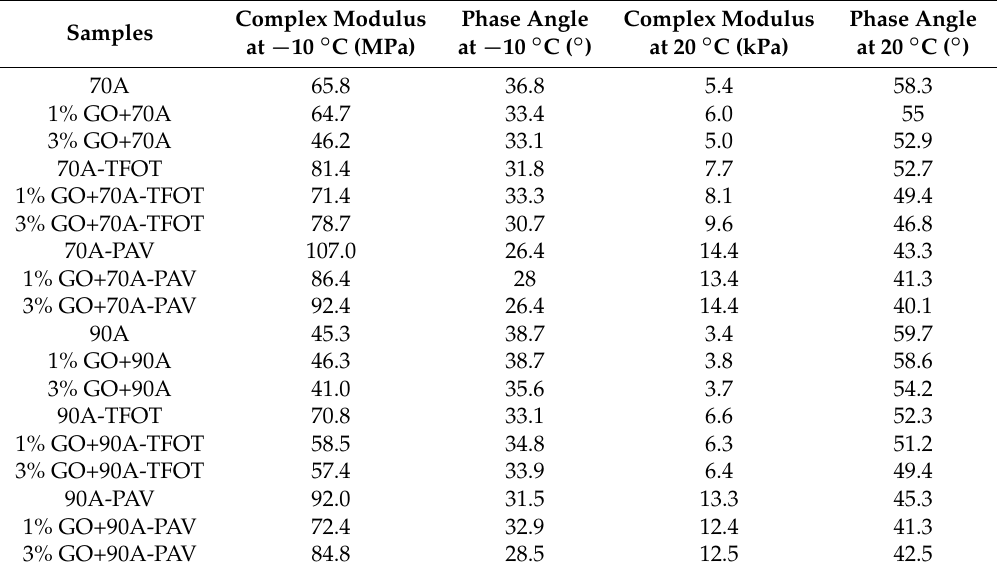
Table 3. Complex modulus and phase angle of GO-modified asphalts and base asphalt before and after different aging processes.